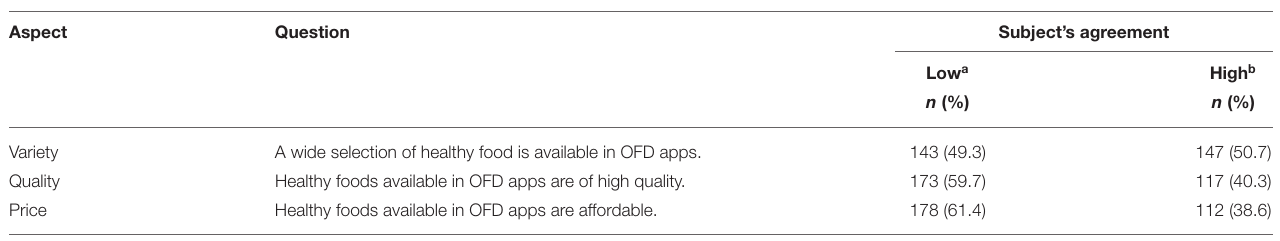
TABLE 6 | Subjects’ responses on healthy food availability in OFD apps based on variety, quality, and price. Aspect